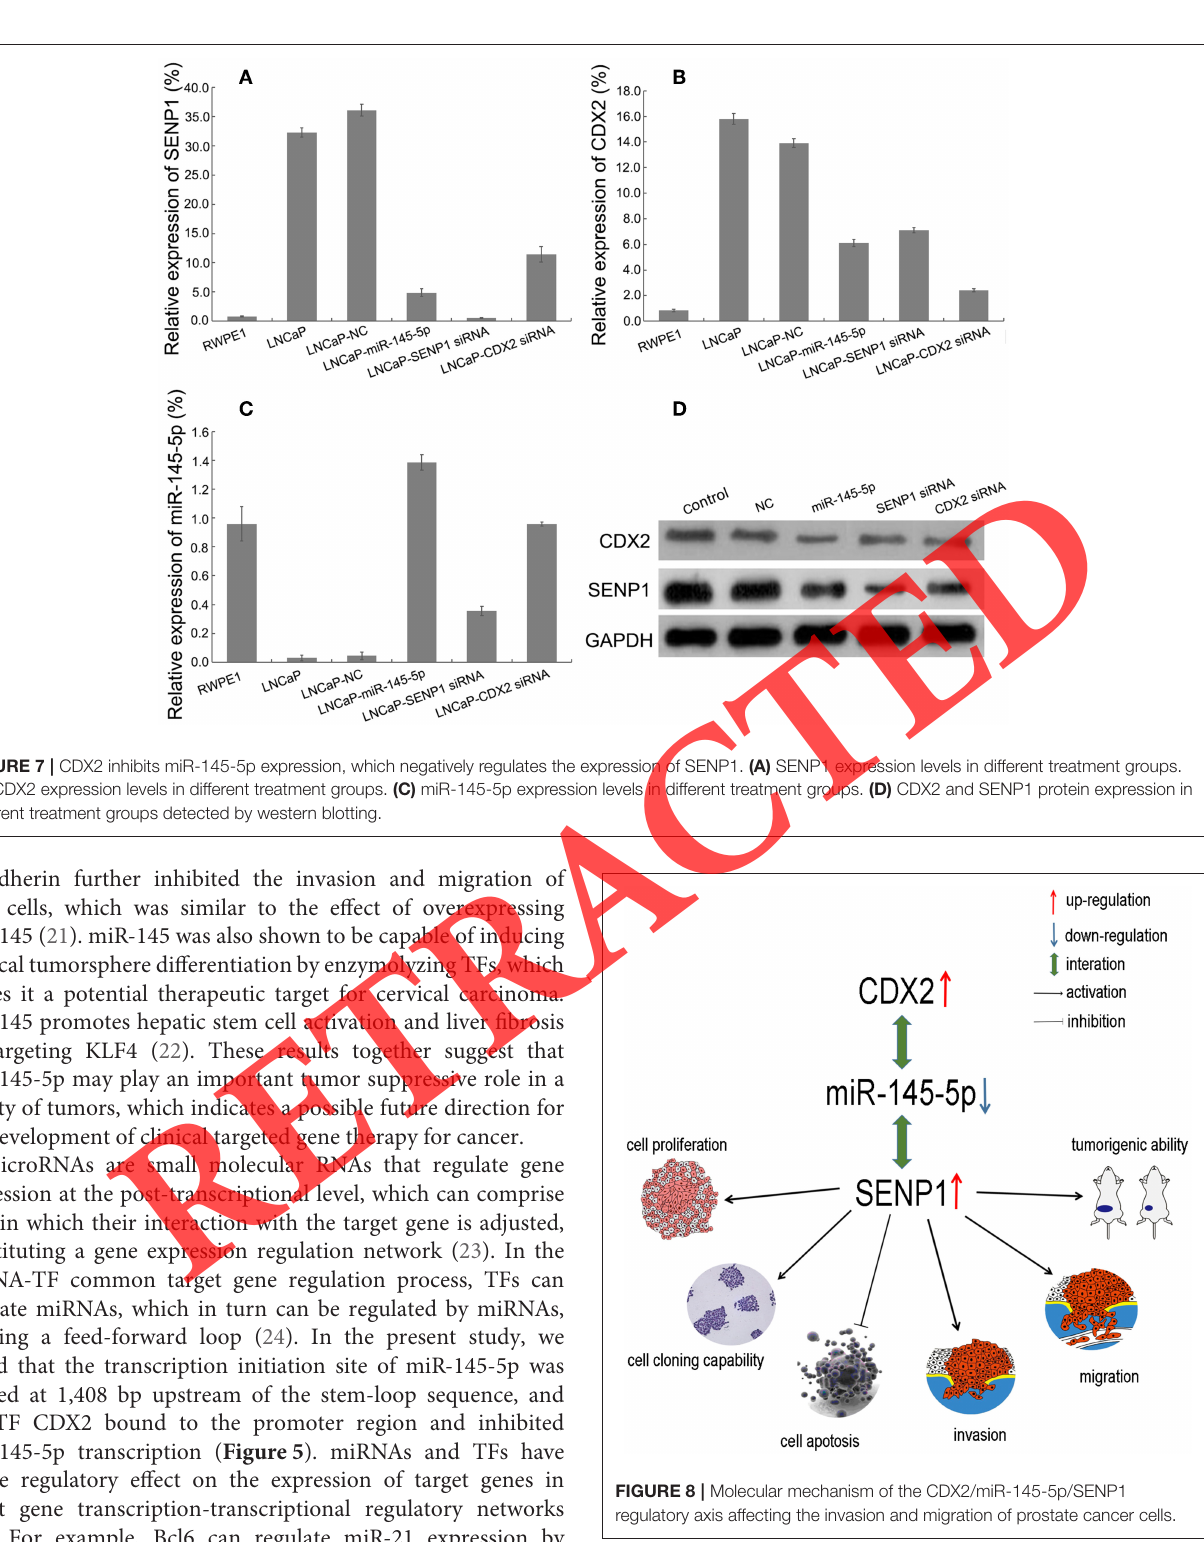
FIGURE 8 | Molecular mechanism of the CDX2/miR-145-5p/SENP1 regulatory axis affecting the invasion and migration of prostate cancer cells.